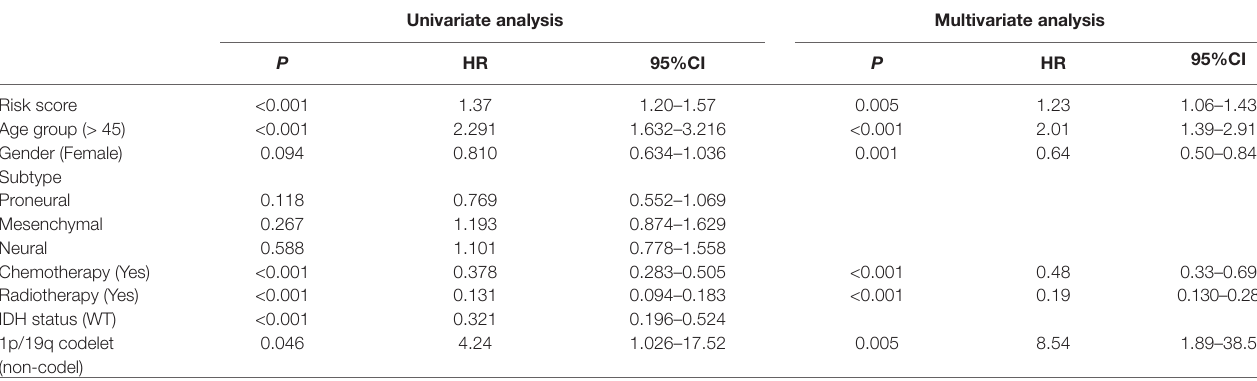
TABle 2 | Univariate and multivariate Cox regression analysis of factors affecting overall survival of patients in The Cancer Genome Atlas (TCGA) glioblastoma (GBM) cohort. Univariate analysis Multivariate